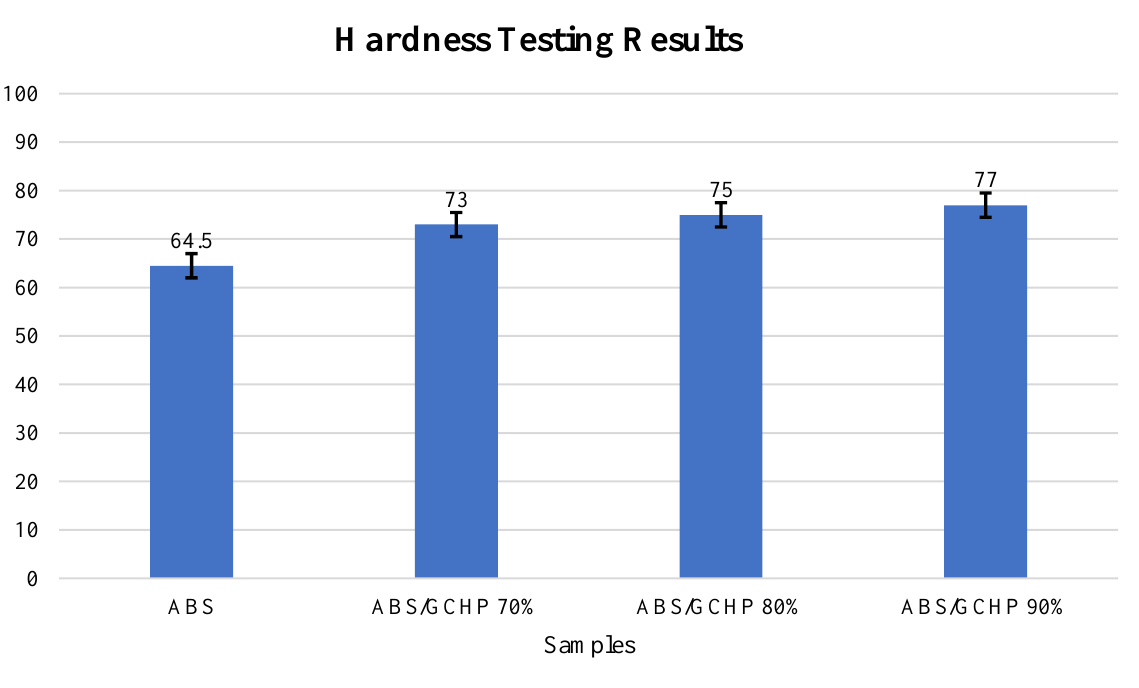
Figure 21. Hardness testing results for ABS/HCE composites with ABS. Figure 22 shows the hardness results of ABS/GEP composites with ABS. A single layer of GEP with 0.2 wt.% GNPs added at 70% to ABS showed 75 HD, an increase of 16.28% compared to ABS. ABS/0.2 80% showed slight increase of 77 HD. ABS/0.2 GEP